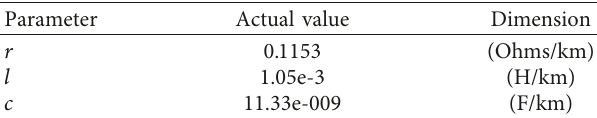
Table 3: Initial parameters of the distribution line test